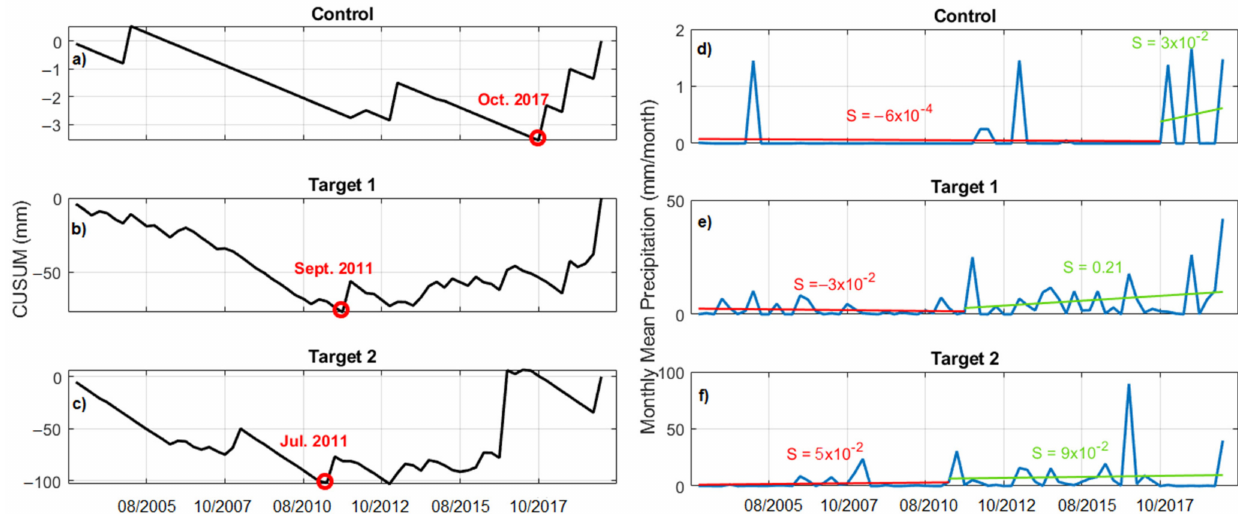
Figure 5. Time series of CUSUM values derived over the ( a ) control area, ( b ) Target Area 1 and ( c ) Target Area 2 which represent the cumulative sum of differences from the mean at each time step. The corresponding gauge-averaged time series ( d – f ) of observed rainfall divided at the detected change points with pre- and post-change point trend lines and slope values are labeled in green and red,